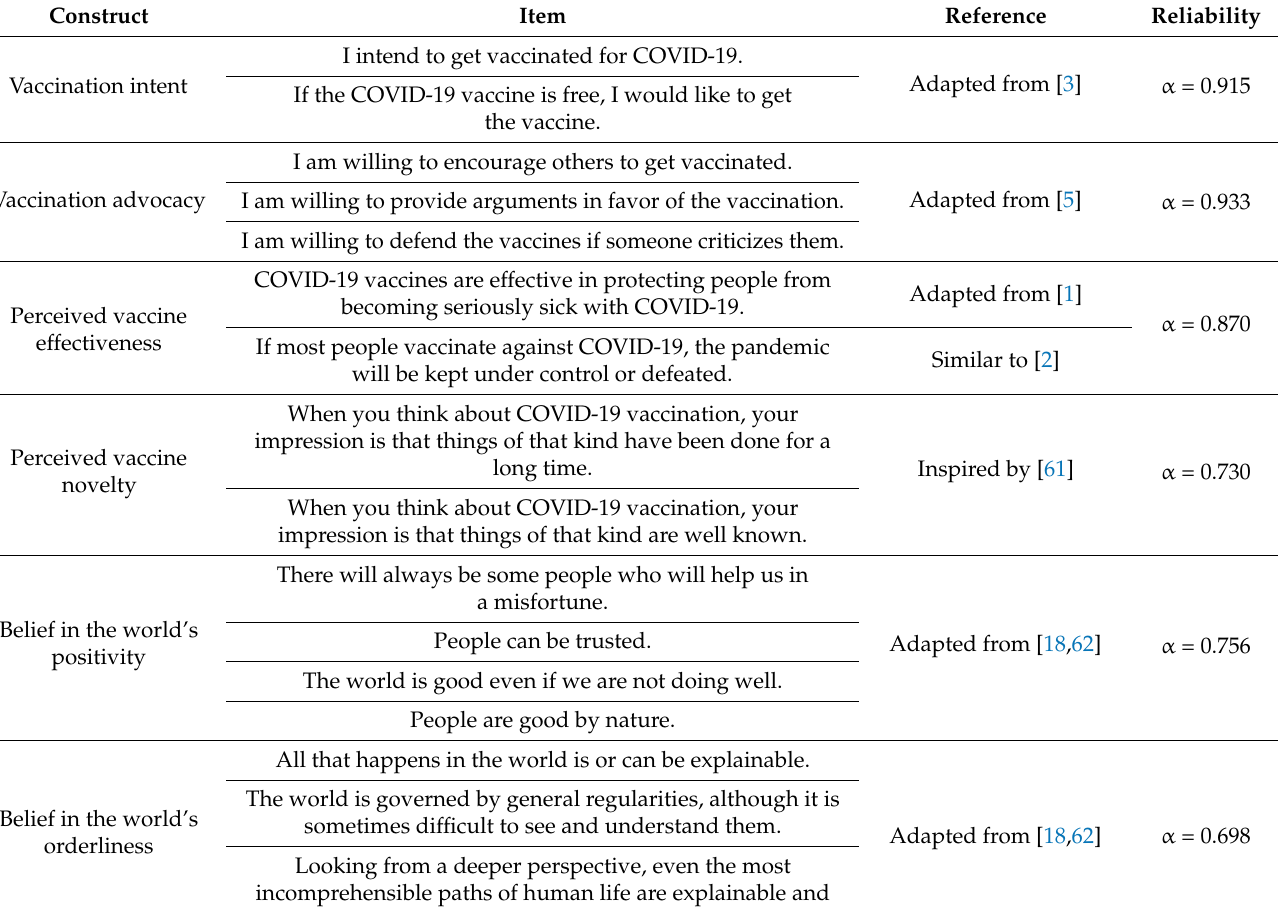
Table 1. The final measurement